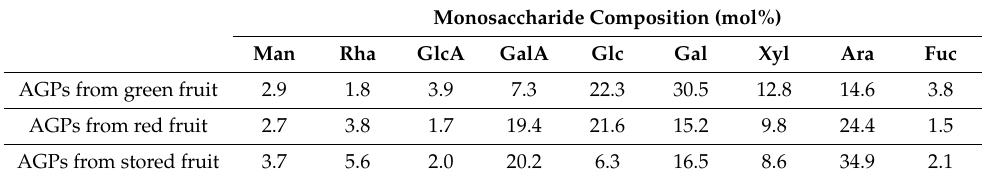
Figure 1. SEM microphotographs of AGPs extracted from fruit at different stages of ripening: green fruit ( a , b ), red fruit ( c , d ) and stored fruit ( e , f ). Bars: 200 nm. Unlike SEM imaging, the HPLC analysis of AGP composition revealed clear differences along ripening time. A characteristic common feature of AGPs at each stage is the high proportion of carbohydrates. Table 1 shows the monosaccharide and uronic acids (UA) composition expressed in mol %. AGPs contained predominantly Ara, Gal, Glc, GalA, and Xyl. Other compounds, including Fuc, Rha, Man, and GlcA, were present in lower amounts. The distribution of monosaccharides and UA was heterogeneous at the ripening stages. AGPs isolated at early stage of development (green fruit) contained substantially higher amounts of Gal (30.5 mol %) than the other samples (15.2 mol % and 16.5 mol % for ‘red’ and ‘stored’ apples, respectively). In turn, the Ara content was distinctly lower in the AGPs in the green fruit (14.6 mol %) than at two other stages (>24.4 mol %). It is clear that the amount of Ara increased progressively along ripening reaching 34.9 mol % after 1 month of storage. The content of Glc was similar in the AGPs from the green (22.3 mol %) and red (21.6 mol %) fruit, and significantly lower in the stored fruit (6.3 mol %). The AGPs from the green fruit contained a visibly lower amount of GalA (7.3 mol %) than the AGPs from the red (19.4 mol %) and stored fruit (20.2 mol %). Table 1. Monosaccharide composition of AGPs (mol %) extracted from fruit at different stages of ripening.